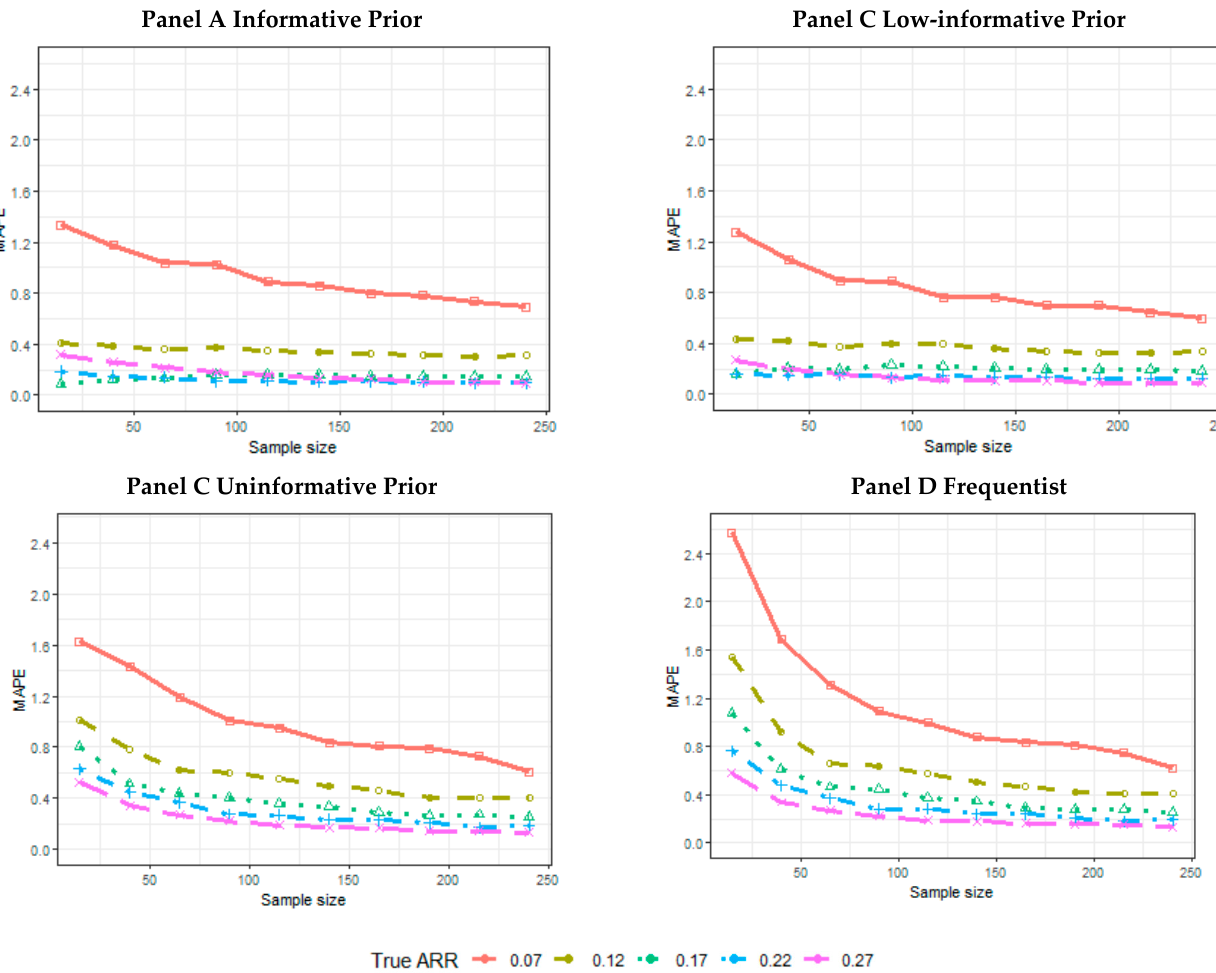
Figure 5. Simulation results for the mean absolute percentage error (MAPE) estimate according to the sample size and true ARR for informative prior (Panel A), low-informative prior (Panel B), uninformative prior (Panel C), and frequentist analyses (Panel D).